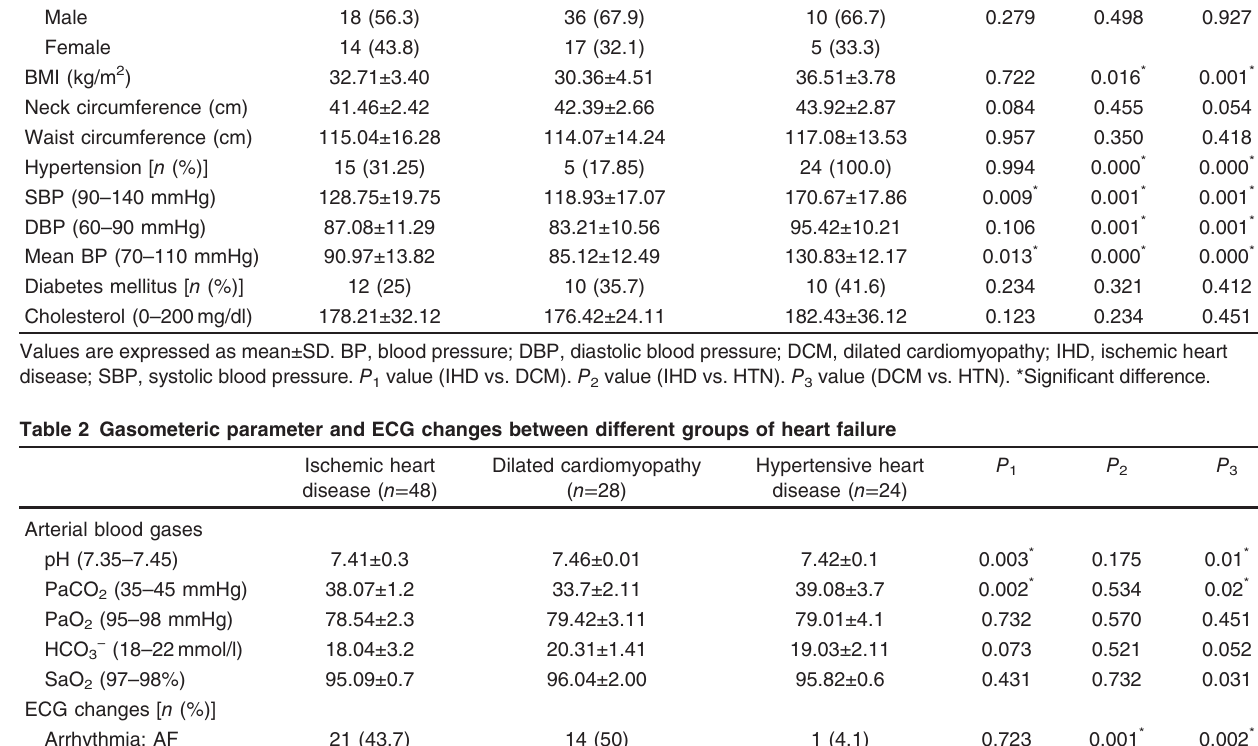
Table 1 Patient characteristics, anthropometric measures, and comorbidities among different groups of heart failure Ischemic heart disease ( n =